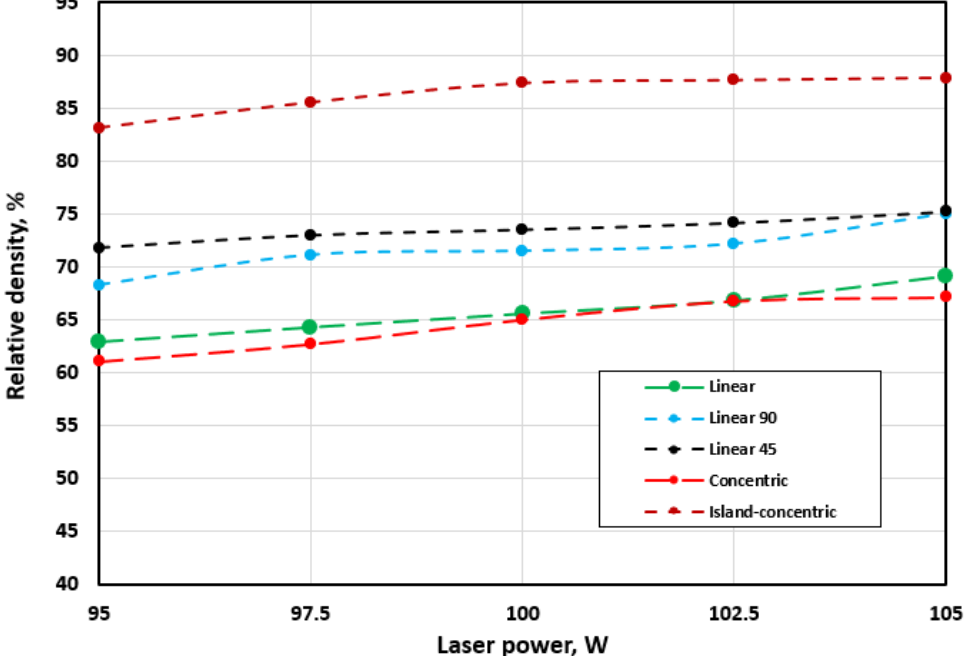
Figure 20. Relative density of alumina samples printed with different scanning strategies using a scanning speed of 20 mm/s and different laser power ranging from 95 to 105 W.